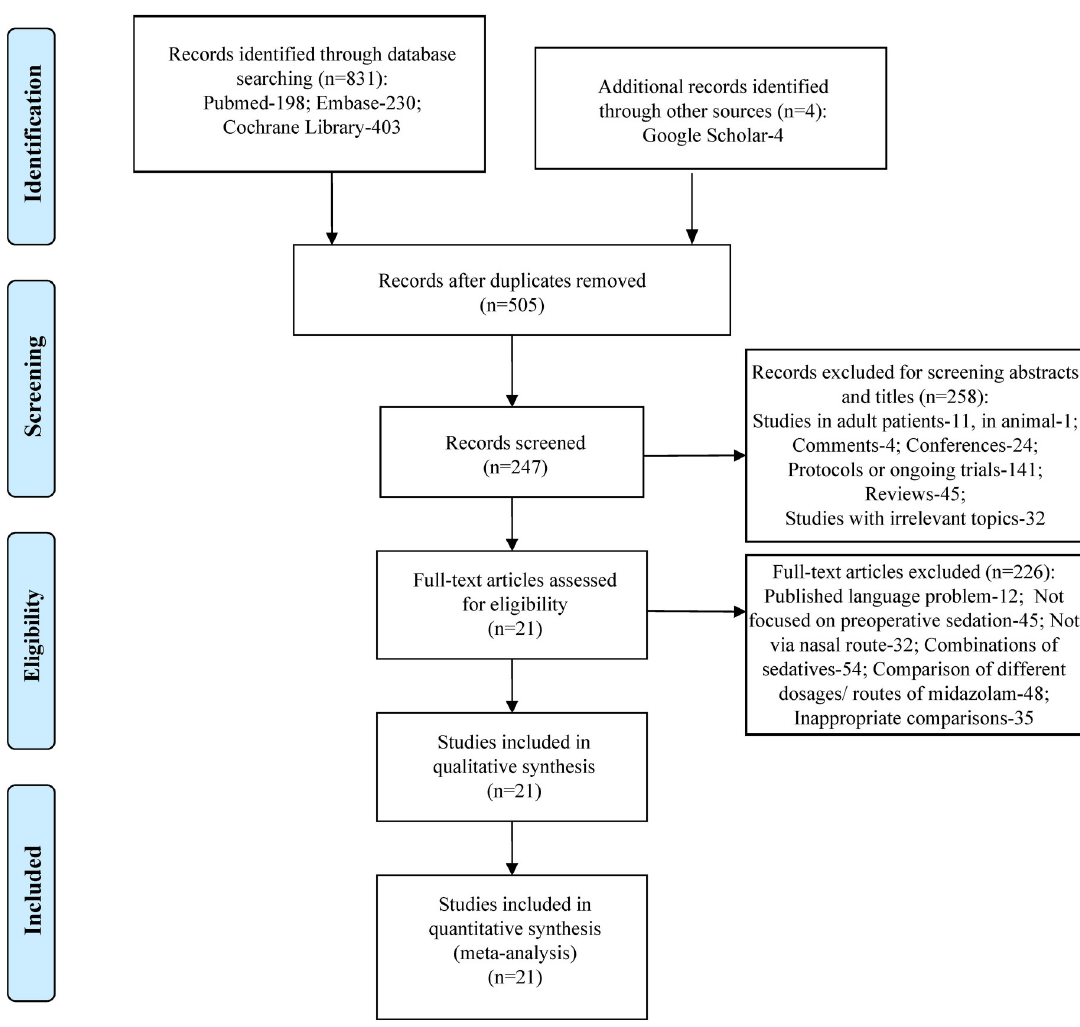
Fig 1. Flow chart of literature screening and the selection